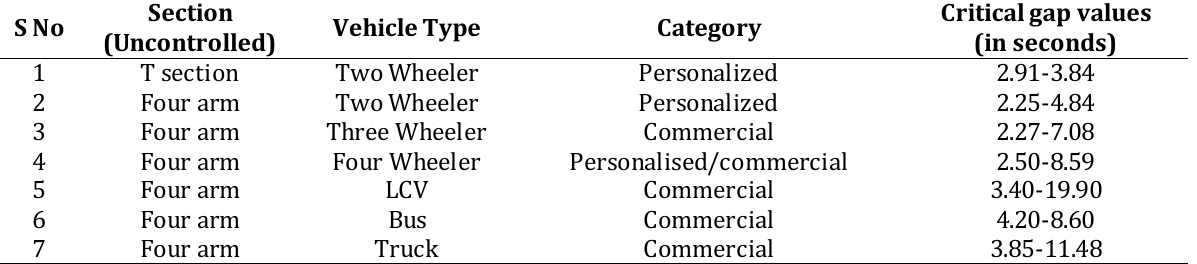
Table 5: Critical gap values for different classes of vehicles S No